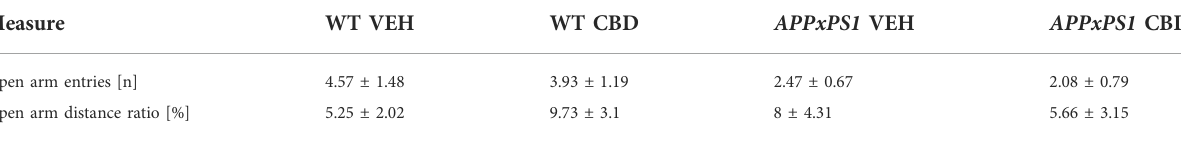
TABLE 2 Open arm measures in the elevated plus maze test. Open arm entries [n] and the open arm distance ratio [%] in WT and APPxPS1 mice, following chronic treatment with a vehicle or 20 mg/kg CBD. Data presented as mean ± SEM. Measure WT VEH WT